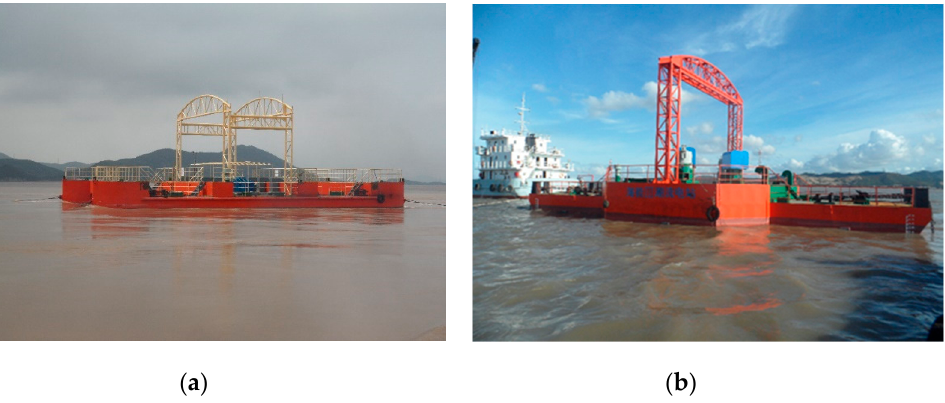
Figure 2. Prototypes of HaiNeng series, ( a ) 2 × 150 kW “HaiNeng Ⅰ ”; ( b ) 2 × 300 kW “HaiNeng Ⅲ ”.